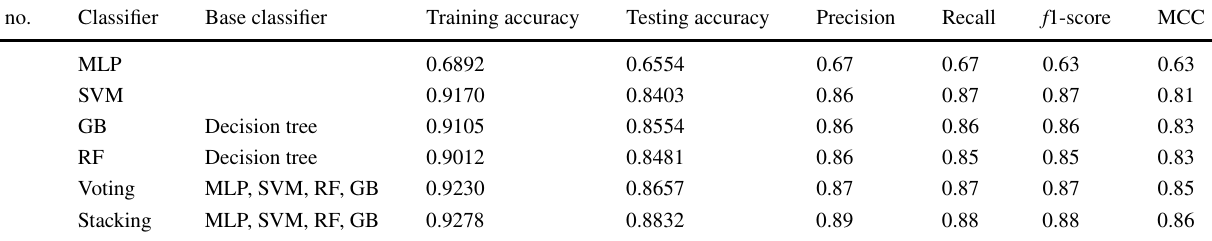
Table 7 Classification accuracy of six machine learning models depicted on training (80%) and testing (20%) datasets for lithofacies classifica- tion S.